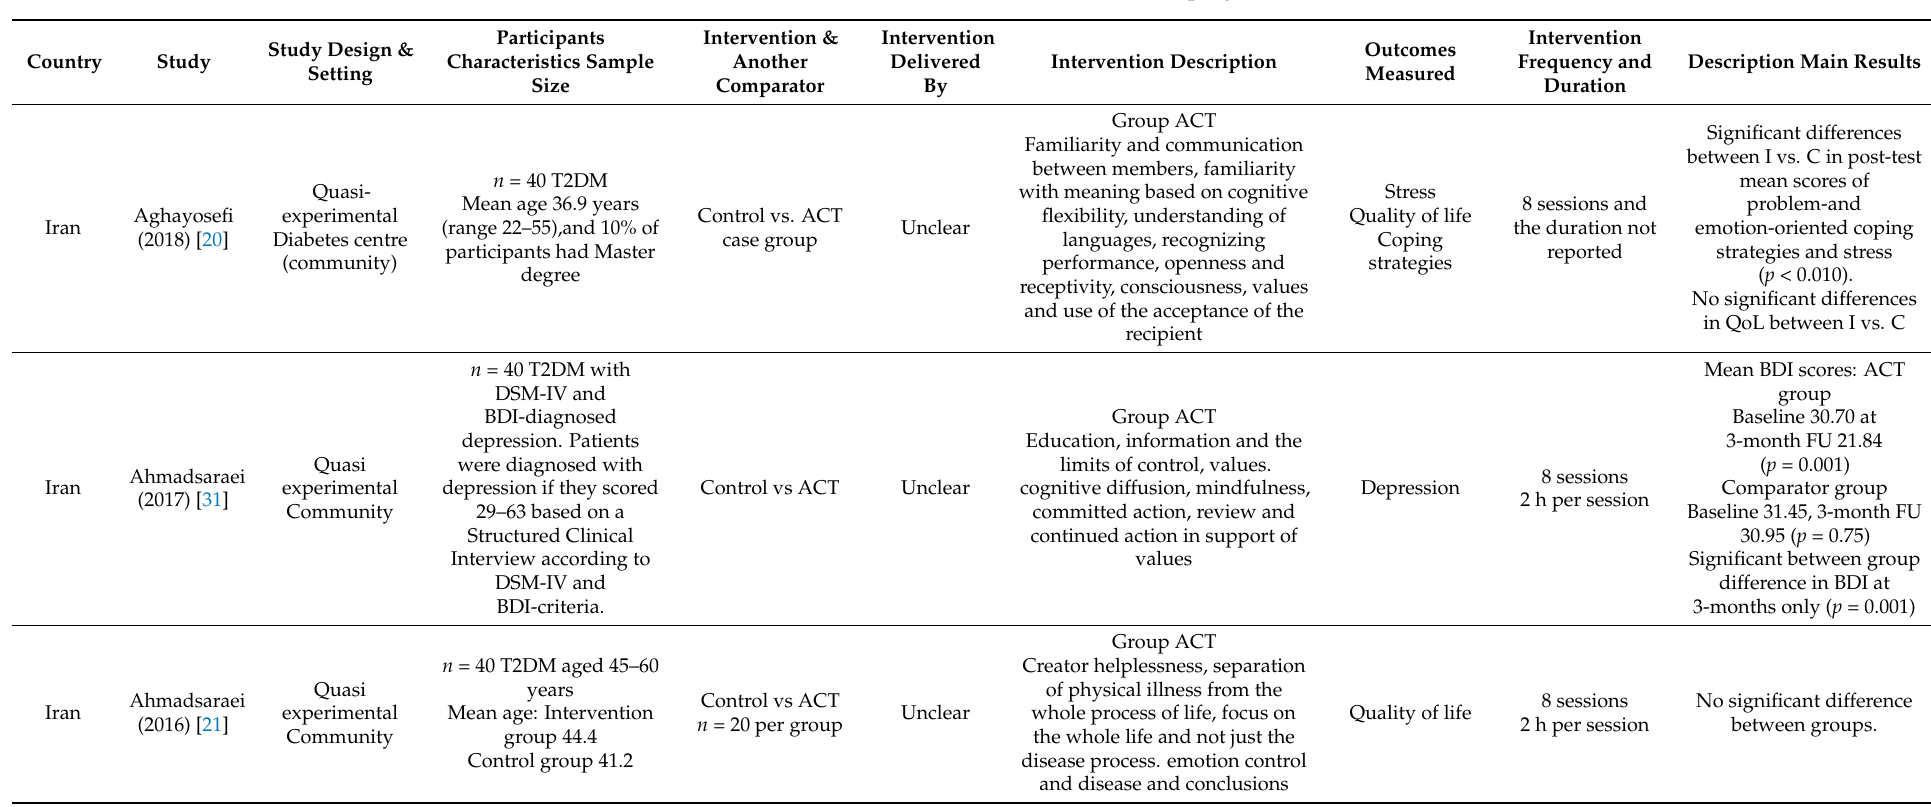
Table A1. Characteristics of Included Studies for the Scoping